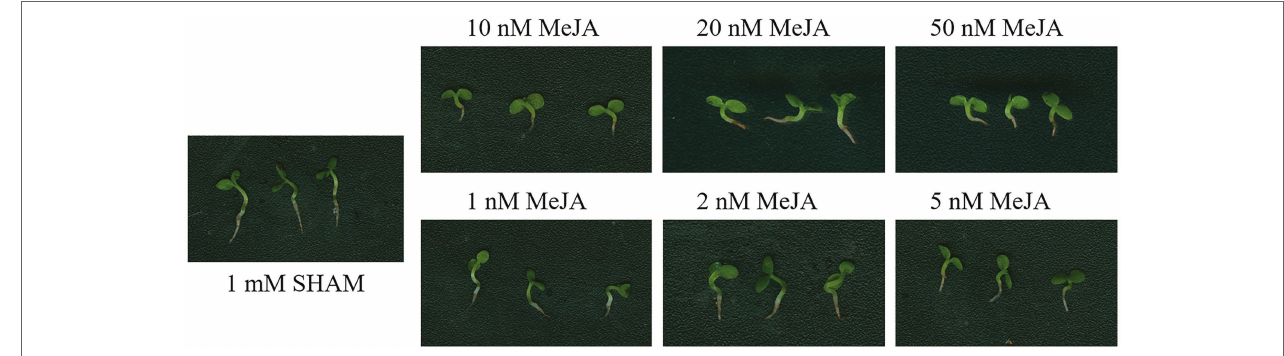
FIGURE 10 | Effects of adding methyl jasmonate (MeJA) on the root development of SHAM treatment. The root development on the 8th day of samples treated with 1 mM SHAM (CK) and treated with SHAM plus different concentrations of MeJA are shown.